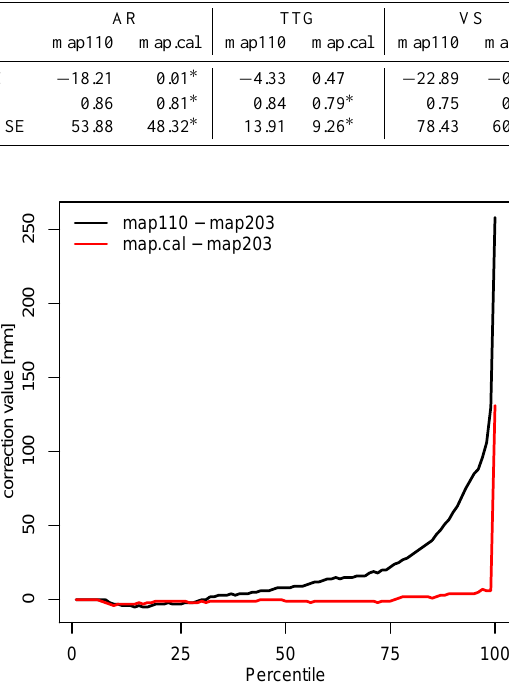
Fig. 9. Differences in percentiles between map203 and map110 (black line) and map203 and map.cal (red line) for the Alpine Rhine during the calibration period.